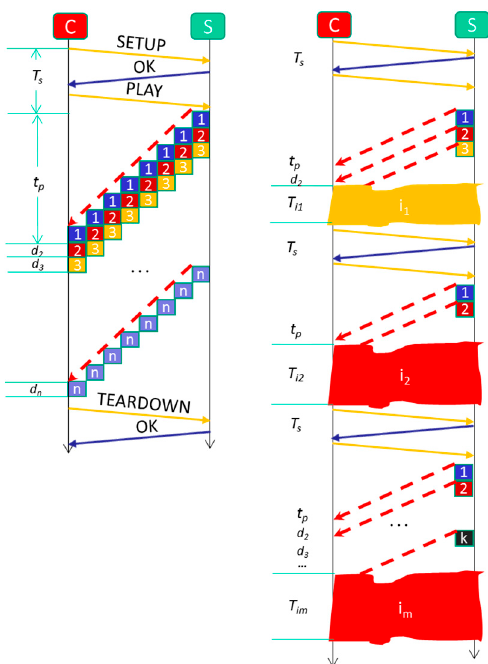
Figure 9. Communication times without and with video service disruptions.